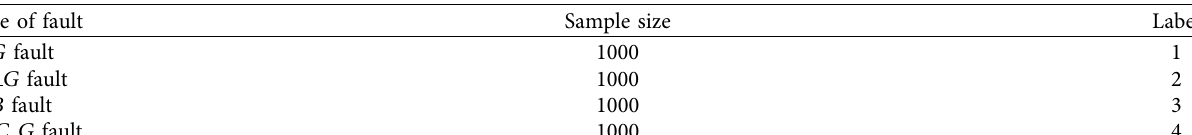
Figure 6: Waveforms of various short-circuit fault current after denoising. (a) A_G fault. (b) AB_G fault. (c) ABC_G fault. (d) A_B fault. Table 3: Collection quantity of various signal samples.